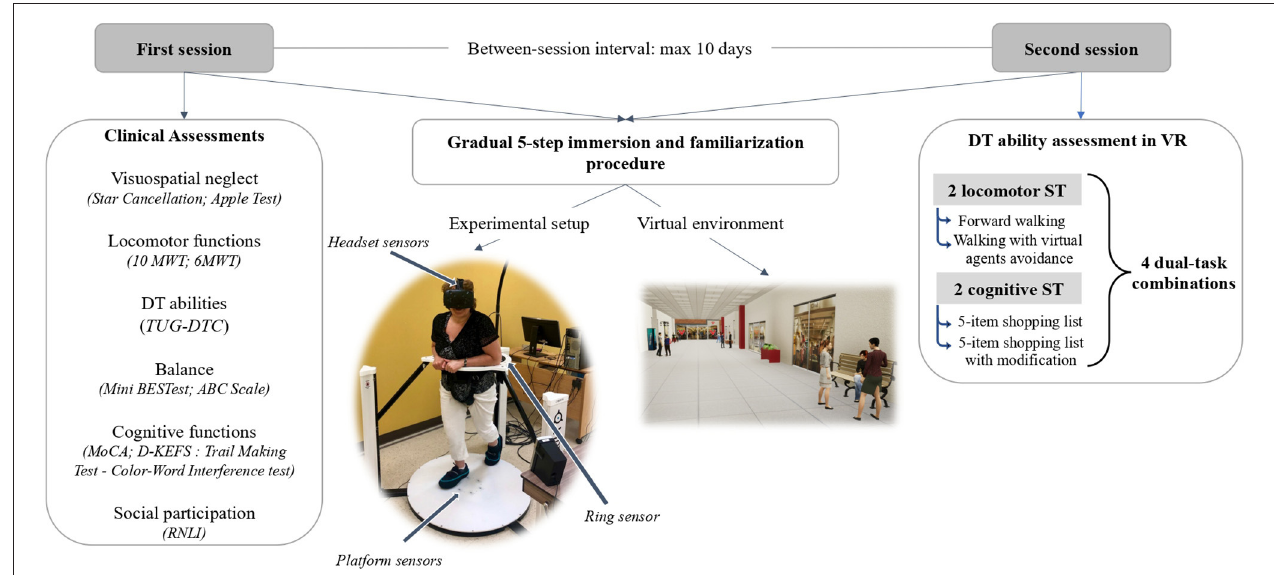
FIGURE 1 | Experimental setup. 6MWT, 6-min Walk Test; 10MWT, 10-meter Walk Test; ABC Scale, Activities-Specific Balance Confidence Scale; D-KEFS, Delis-Kaplan Executive Functions System; DT, dual-task; Mini BESTest, Mini Balance Evaluation Systems Test; MoCA, Montreal Cognitive Assessment; ST, single task; RNLI, Reintegration of Normal Living Index; TUG-DTC, Dual-task cost of Timed-Up Go; VR, virtual